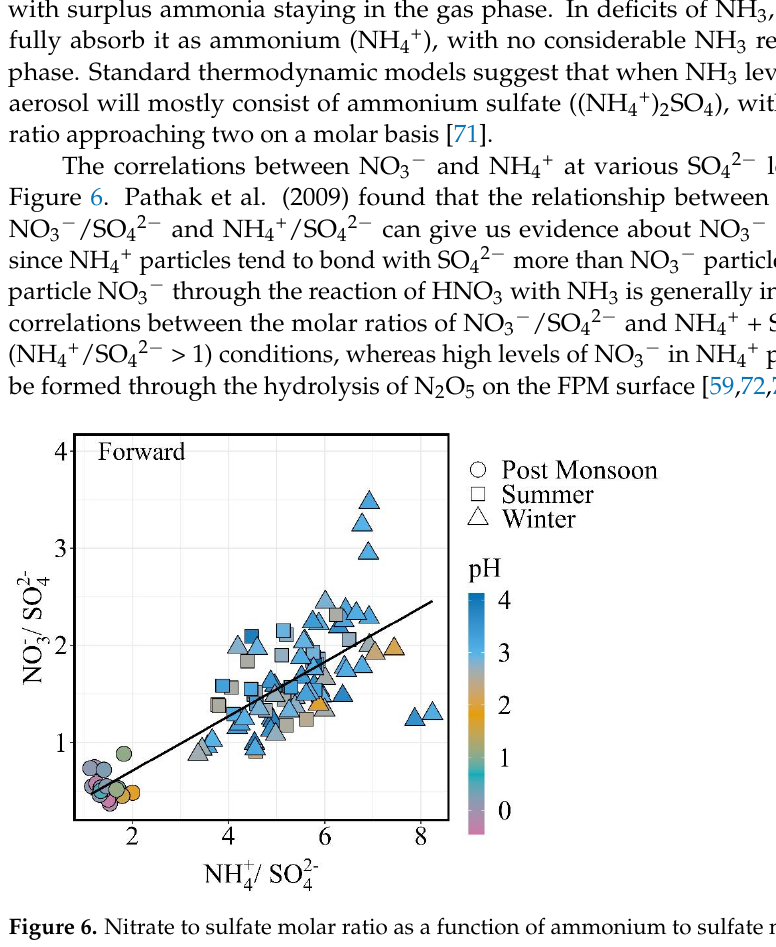
Figure 6. Nitrate to sulfate molar ratio as a function of ammonium to sulfate molar ratio.